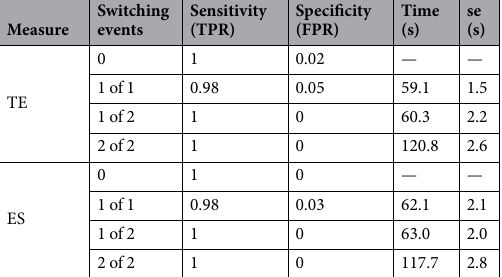
Table 4. Performance of the method and estimated time of leadership switching in the fish